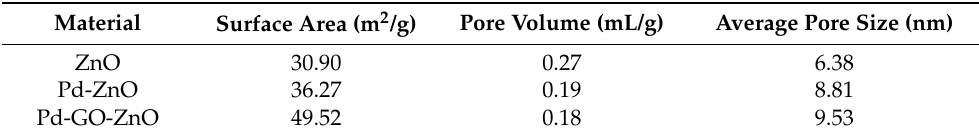
Figure 4. Nitrogen physisorption isotherms of the photocatalysts. Table 1. Textural